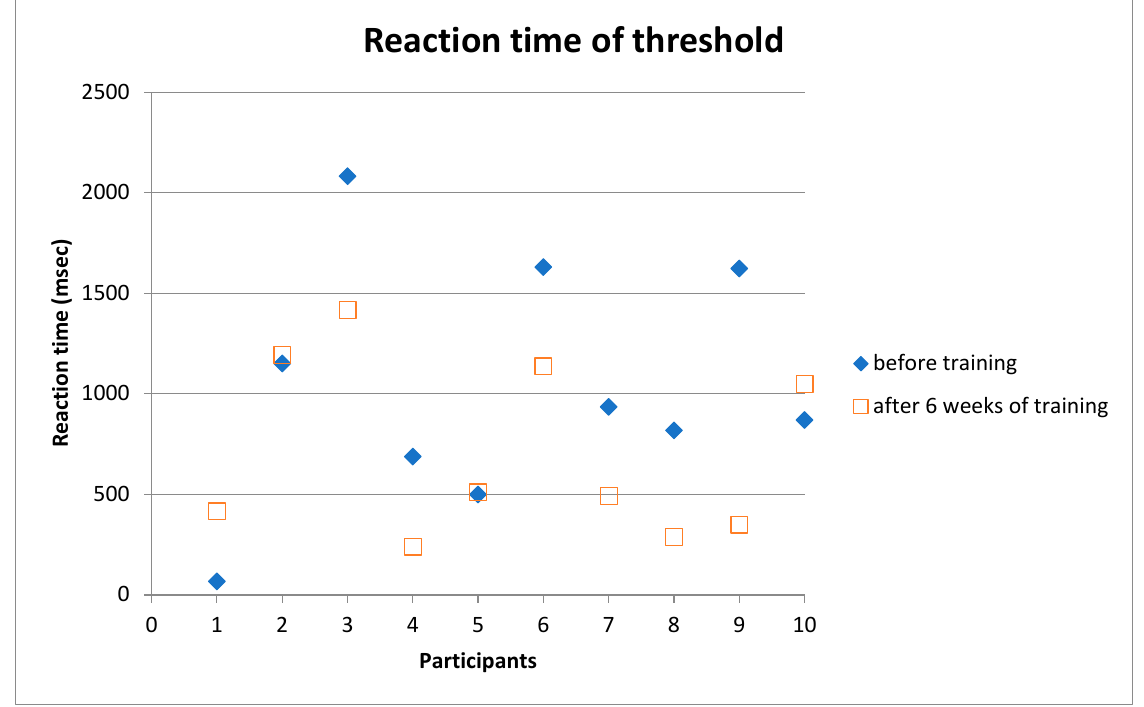
Figure 5. Reaction time recorded by the static test before training and after six weeks of training of ten participants without the participant showing an improvement of 14.131 msec.